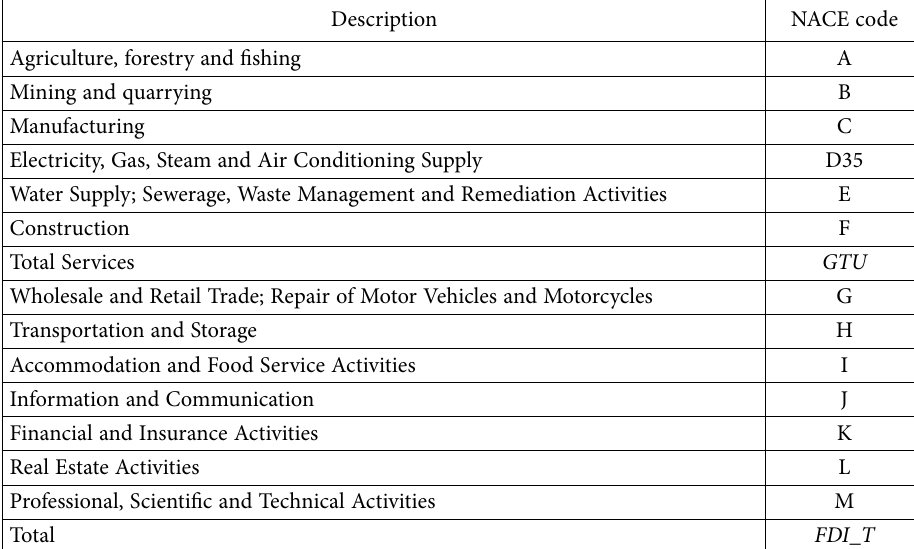
Table A2. National economy by sectors NACE rev.2